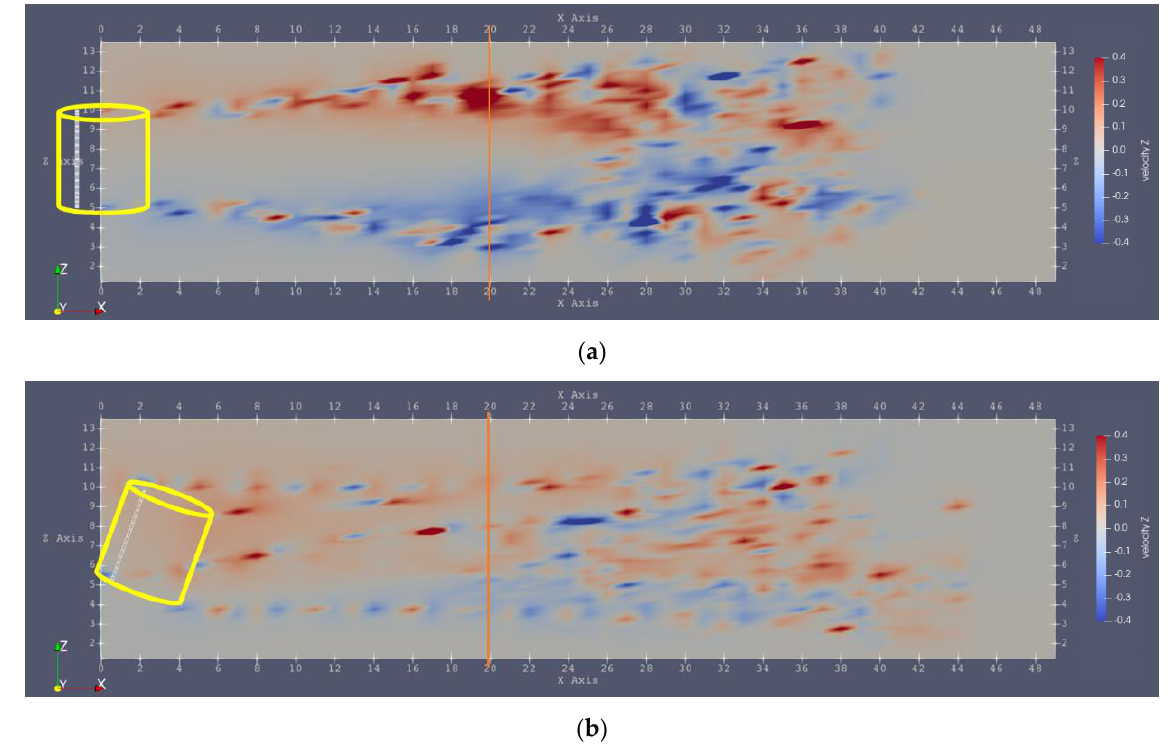
Figure 8. Contour of the vertical component of wind velocity: ( a ) upright; ( b ) 20-degree tilt.